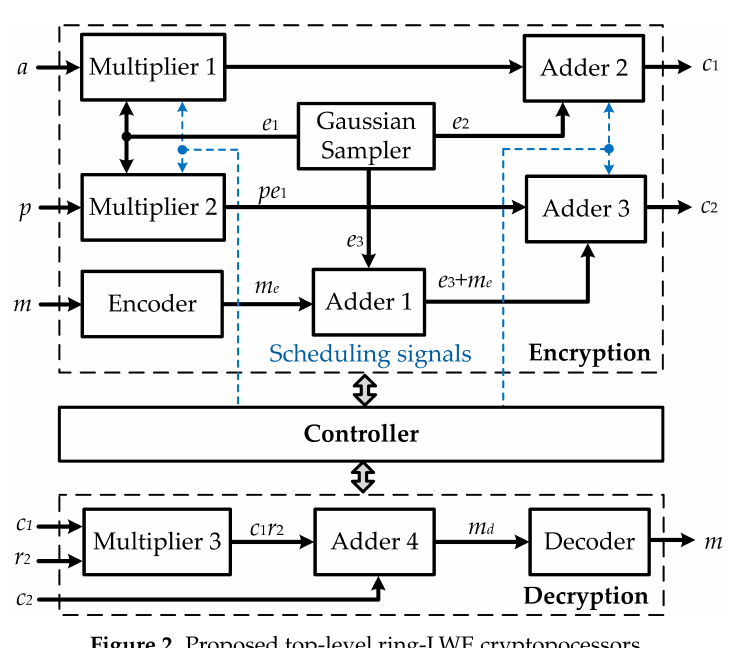
Figure 2. Proposed top-level ring-LWE